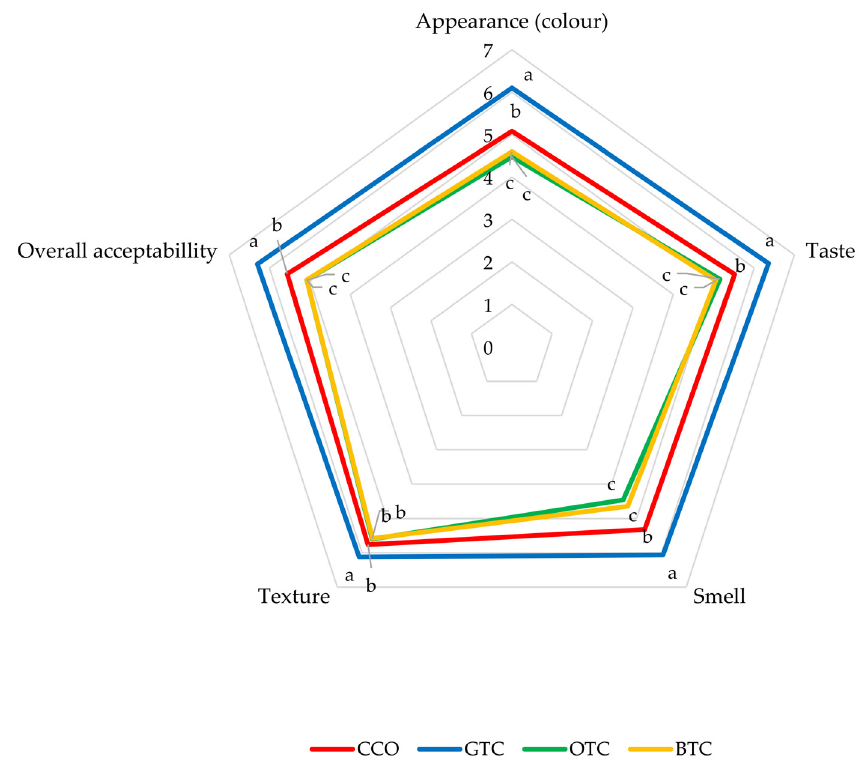
Figure 3. Sensory properties of non-gluten shortbread cookies with various spent tea leaf powders. The mean ± SD ( n = 3). Different letters indicate significant differences between the values (Duncan’s multiple range test, p < 0.05, a–c cookie samples). CCO = control; GTC = non-gluten shortbread cookie with spent green tea leaves powder; OTC = non-gluten shortbread cookies with spent oolong tea leaves powder; BTC = non-gluten shortbread cookies with spent black tea leaves powder; 1 = extremely dislike; 2 = moderately dislike; 3 = slightly dislike; 4 = neither like nor dislike; 5 = slightly like; 6 = moderately like; and 7 = extremely